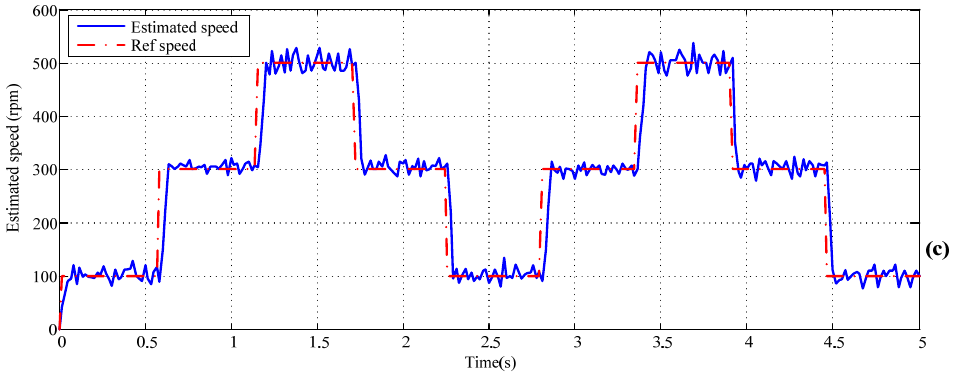
Figure 15. The speed step responses of 0-100-300-500-300-100 rpm with loading of 2 Nm by (a) encoder, (b) ISMO, and (c) NN-ISMO, respectively.